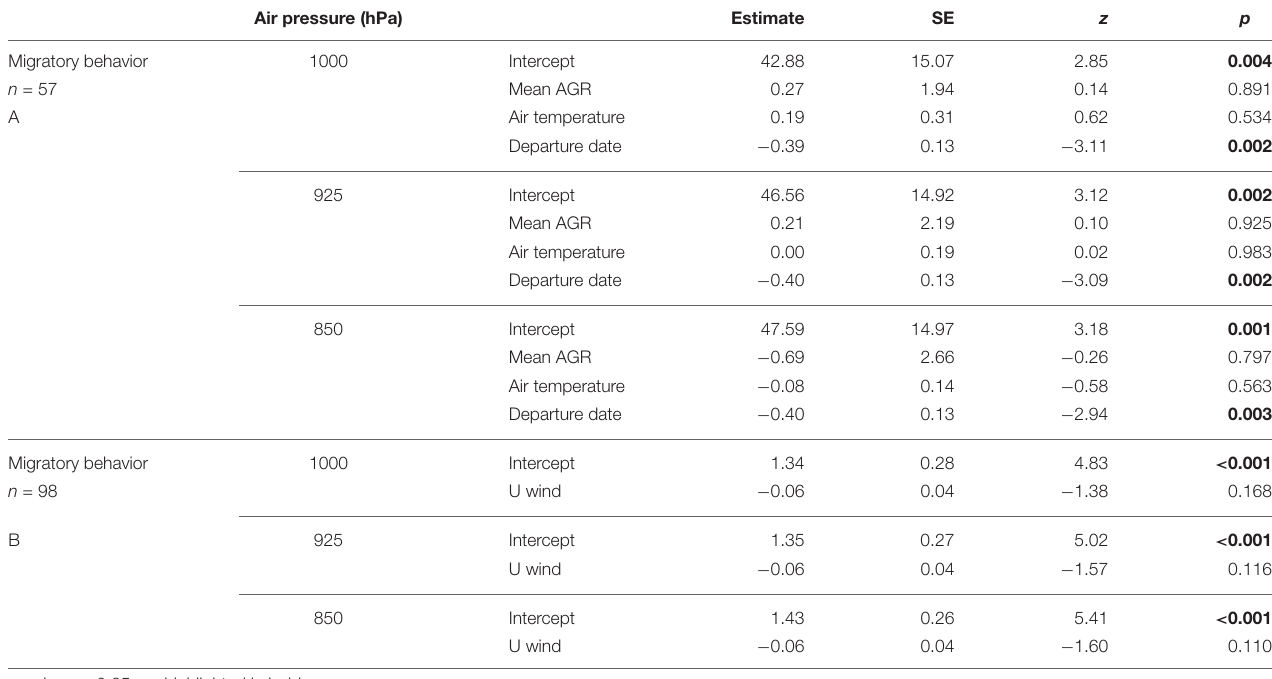
TABLE 1 | Generalized linear models testing potential drivers of spring migratory behavior (direct vs. stopover): (A) individual mean air-to-ground speed ratio (AGR) experienced up to crossing 42 ◦ N, air temperature at 42 ◦ N and departure date from the wintering sites; and (B) zonal wind (east/westward) experienced between 37 and 50 ◦ N, for all locations recorded across individuals.